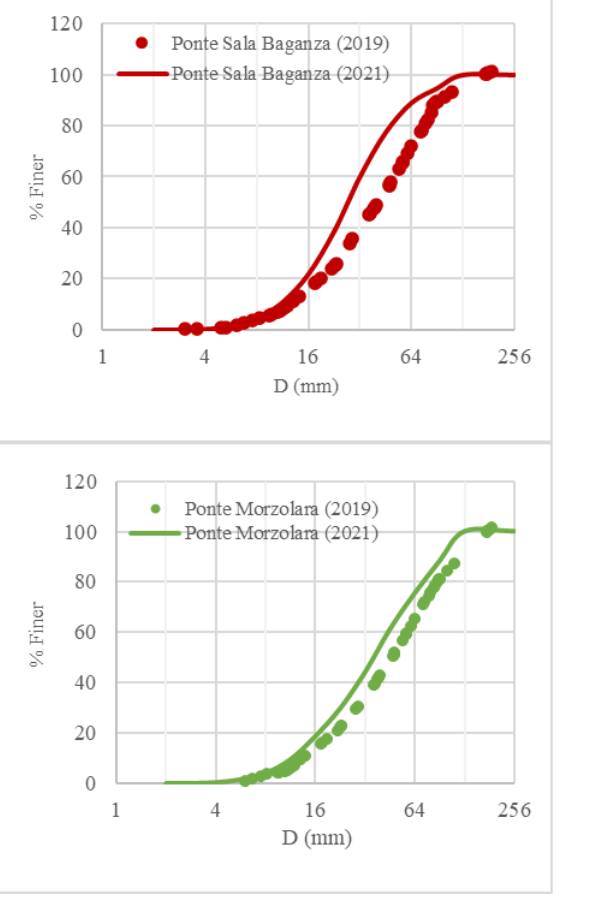
Figure 10. The individual grain size distribution of the surface sediments at each investigated section (the photogrammetric technique).